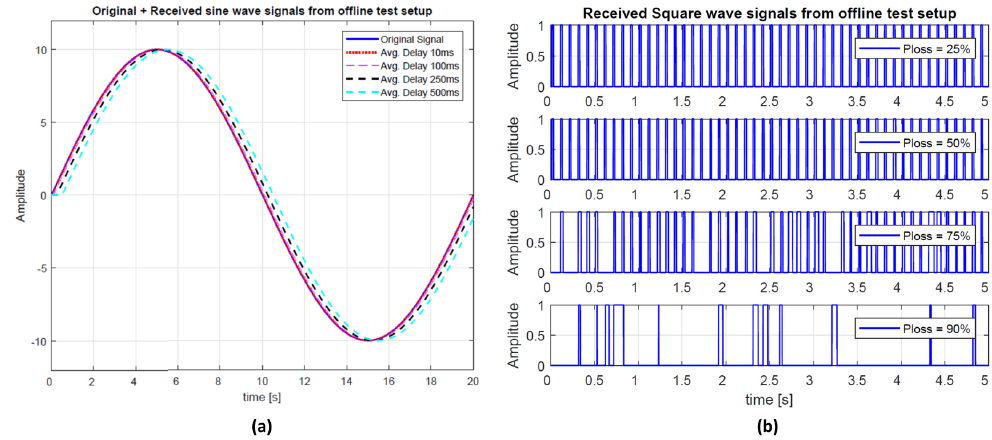
Figure 11. Test Results from off-line setup showing received: ( a ) sine wave signals obtained through a network with four different average delay patterns; and ( b ) square wave signals obtained through a network with four different packet loss rates with a Mean Squared Error (MSE) of around 5.0765 × 10 − 4 .